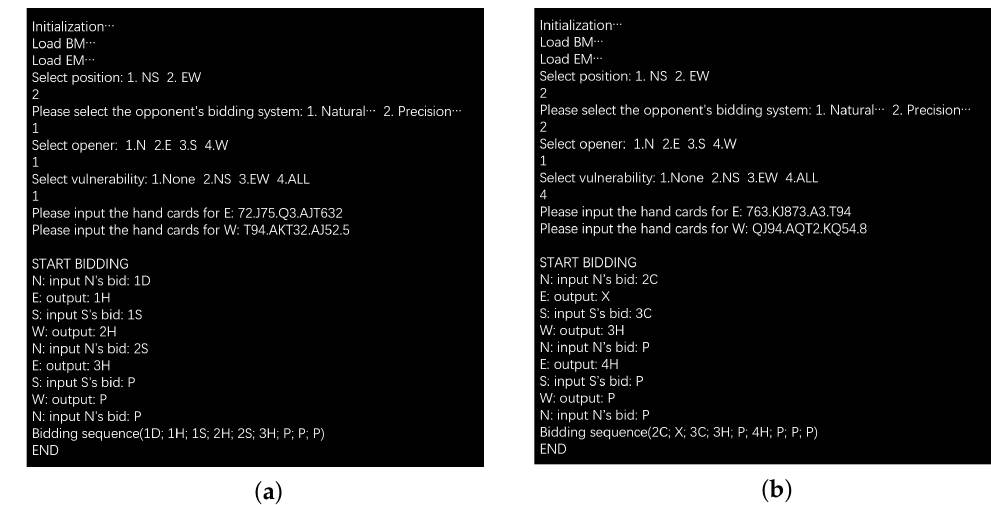
Figure 15. Example of System Testing. ( a ) Bidding with Natural System. ( b ) Bidding with Preci- sion